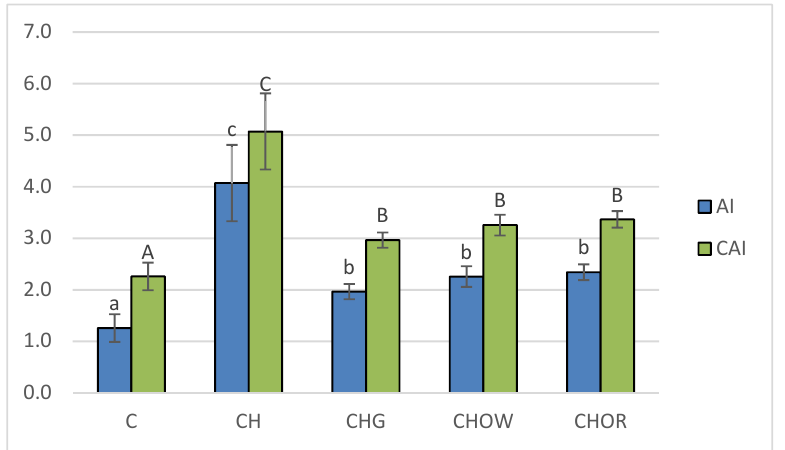
Figure 2. Changes in atherogenic indices (AI and CAI) in rats fed control and cholesterol-containing (1% of cholesterol) diets supplemented with lyophilized vegetables (garlic, white onion, and red onion) during the 28 day experiment. Values are means of 6 measurements ± SD. Means in bars with different superscripts letters in common differ significantly ( p < 0.05): a–c indicate values for AI and A–C indicate values for CAI. Abbreviations: C—control group; CH—control group with 1% of cholesterol; CHG—group with 1% of cholesterol and lyophilized garlic addition; CHOW—group with 1% of cholesterol and lyophilized white onion addition; CHOR—group with 1% of cholesterol and lyophilized raw red onion addition; AI—atherogenic index, CAI—Castelli’s atherogenic index. The lowest ( p < 0.05) atherogenic indices (AI and CAI) were found in the control